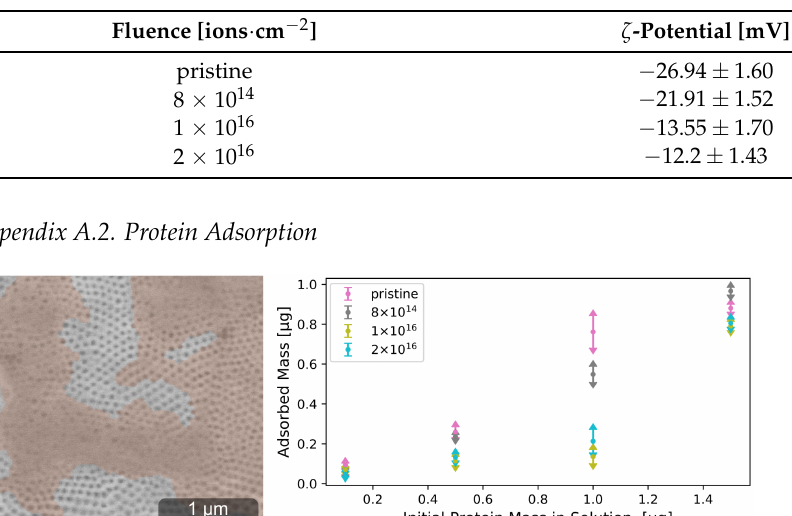
Figure A2. Contact angle measured with sessile drop method ( left ). Obtained dispersive, polar, and total surface free energy using Owens–Wendt–Rabel–Kaelble (OWRK) theory ( right ) [52]. Table A1. ζ -potential of TNSs at pH = 7.